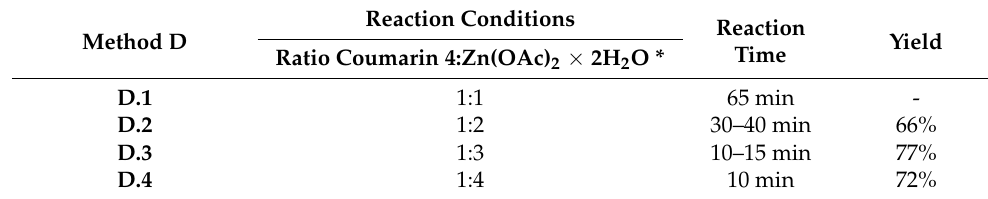
Table 6. Optimization of the applied amount of Zn(OAc) 2 × 2H 2 O in the reaction. Method